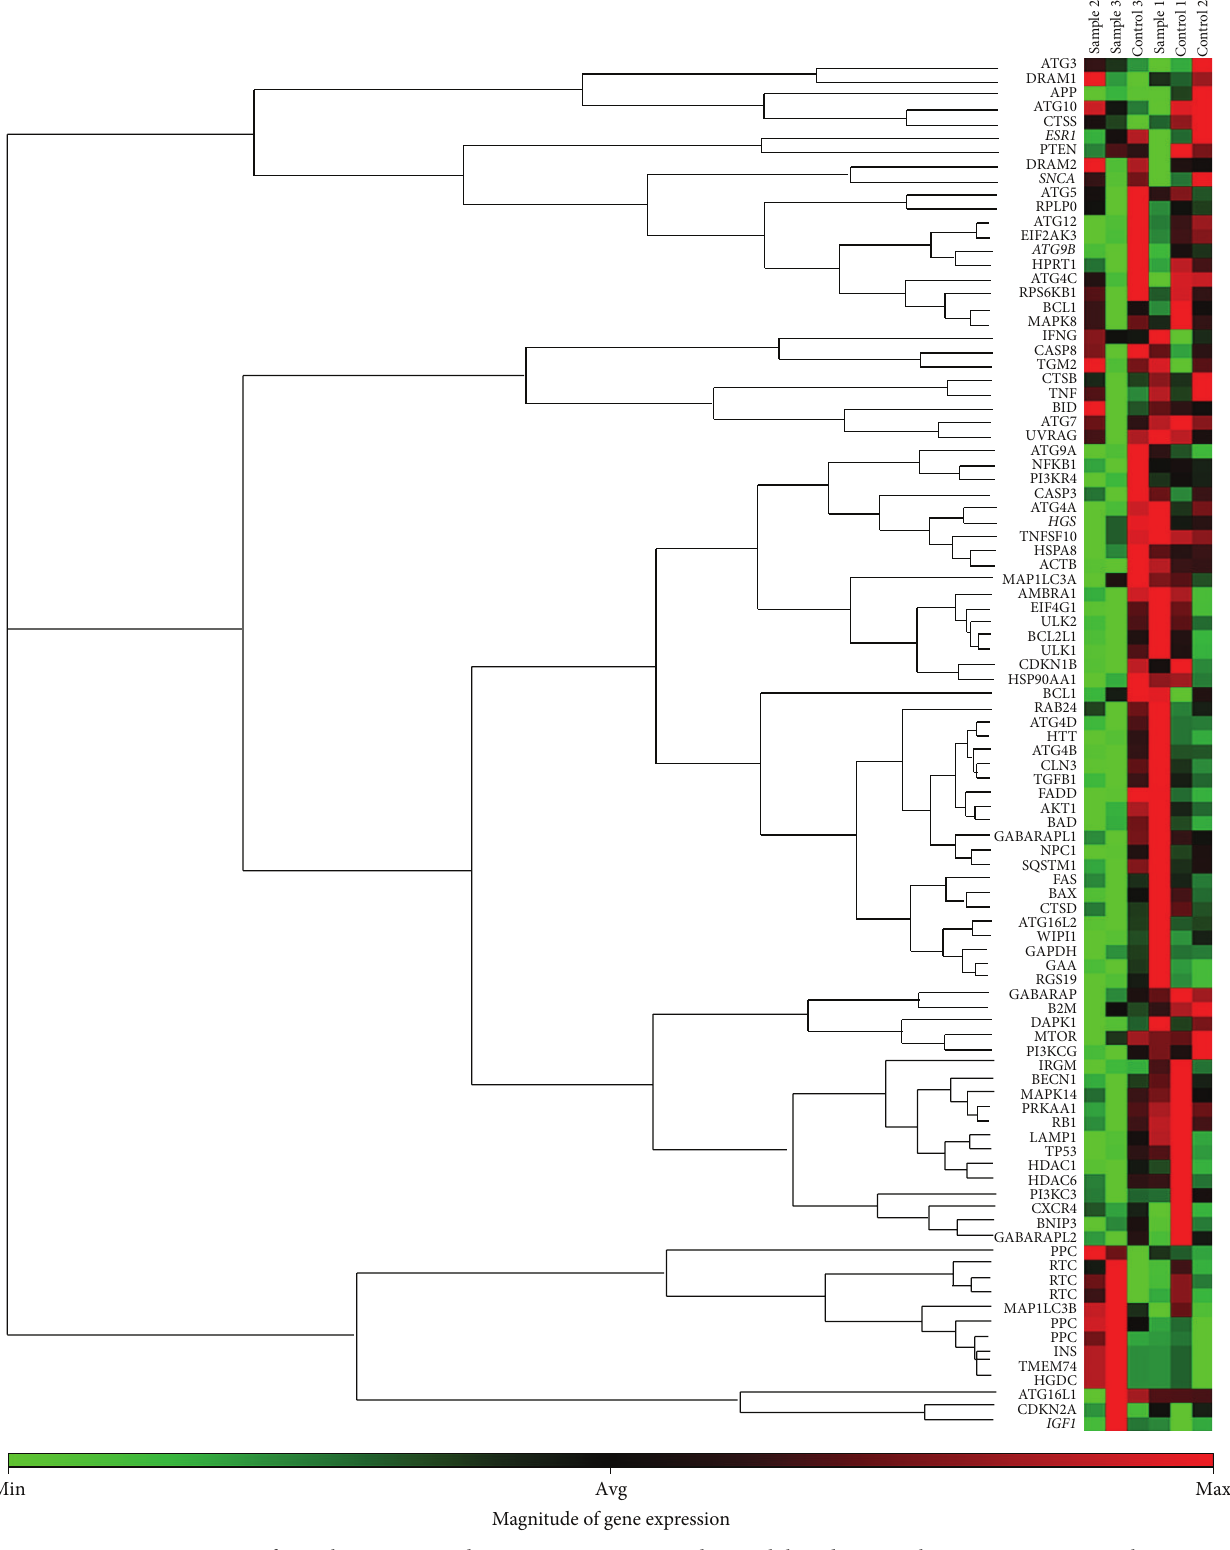
Figure 2: Expression patterns of autophagy-associated genes in OLP patients and controls based on autophagy array. Expression clusters were indicated by color bars next to the genes and subjects that were included in different clusters. The magnitude of gene expression was present at the bottom of the figure, which represented the gene mRNA relative expression levels by a range of color. Different autophagy-associated genes expression profiles in peripheral blood T cells were shown in two OLP forms and controls (sample 1: nonerosive OLP, NEOLP: sample 2 and sample 3: erosive OLP, EOLP, and control 1, control 2, and control 3: healthy